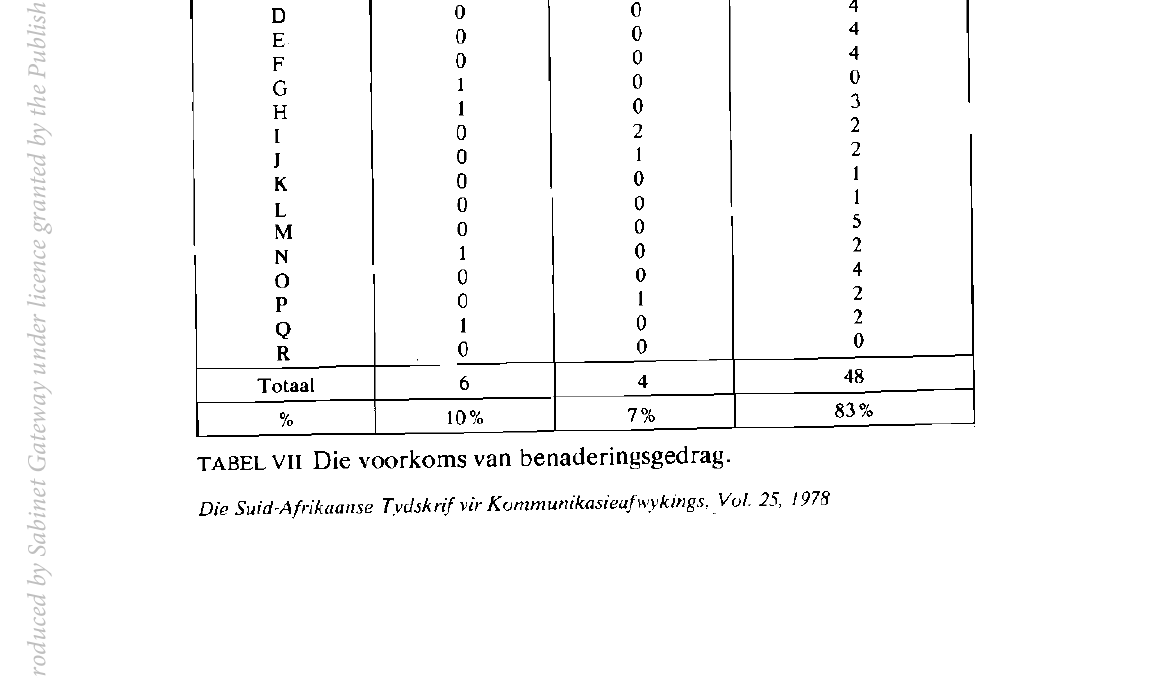
TABEL VI 'n Beoordeling van die voorkoms van die schwa-vokaal by die eerste of enigste woorddeelherhalings van spraakpogings waar